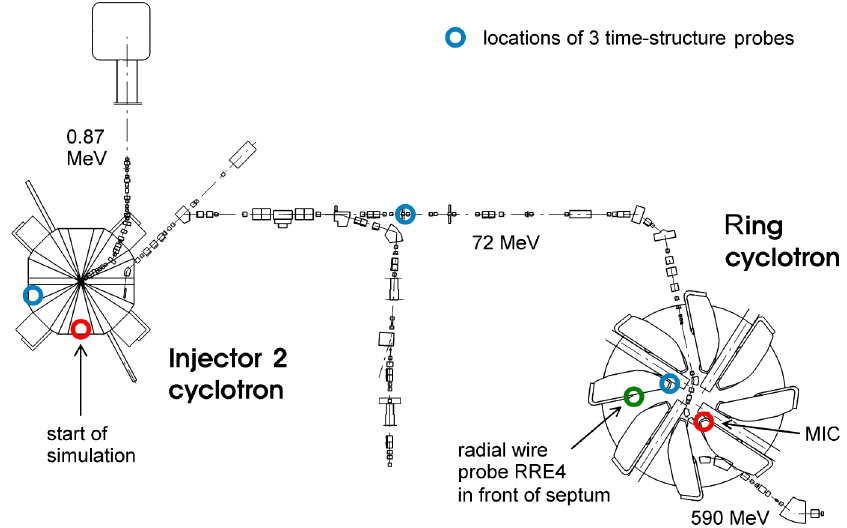
FIG. 1. The PSI Injector 2 cyclotron and beam transfer line to the PSI Ring cyclotron.